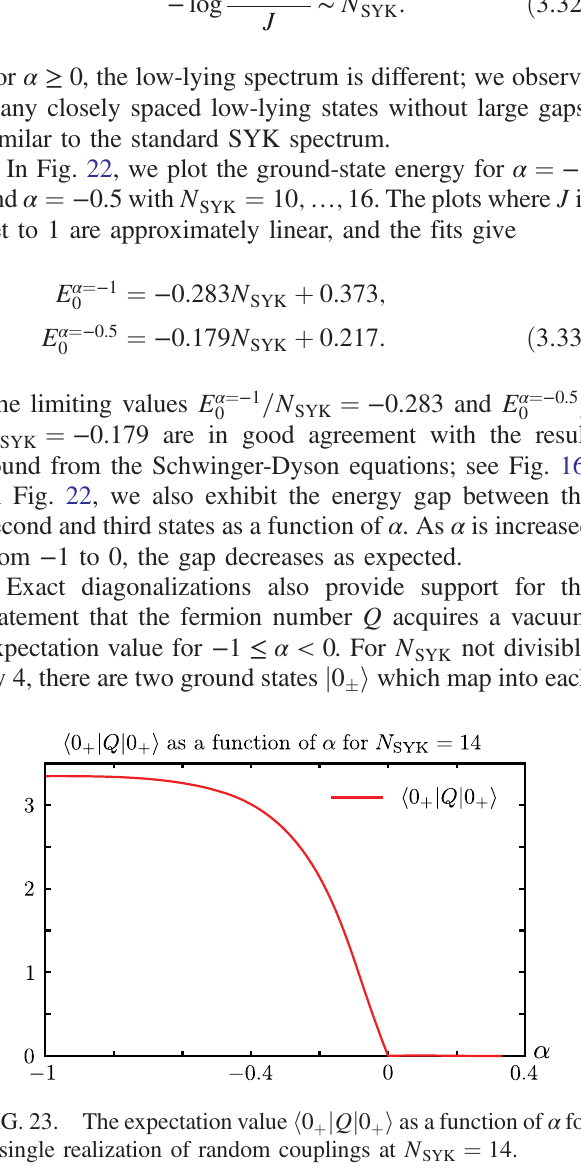
22. Left: The ground-state energy for α ¼ − 0 . 5 , − 1 and N 50 000,5000,5000,2000,500). The linear fit is shown by dashed lines. Right: The energy gap between the second and third states as a function of α for a single realization of random couplings at N